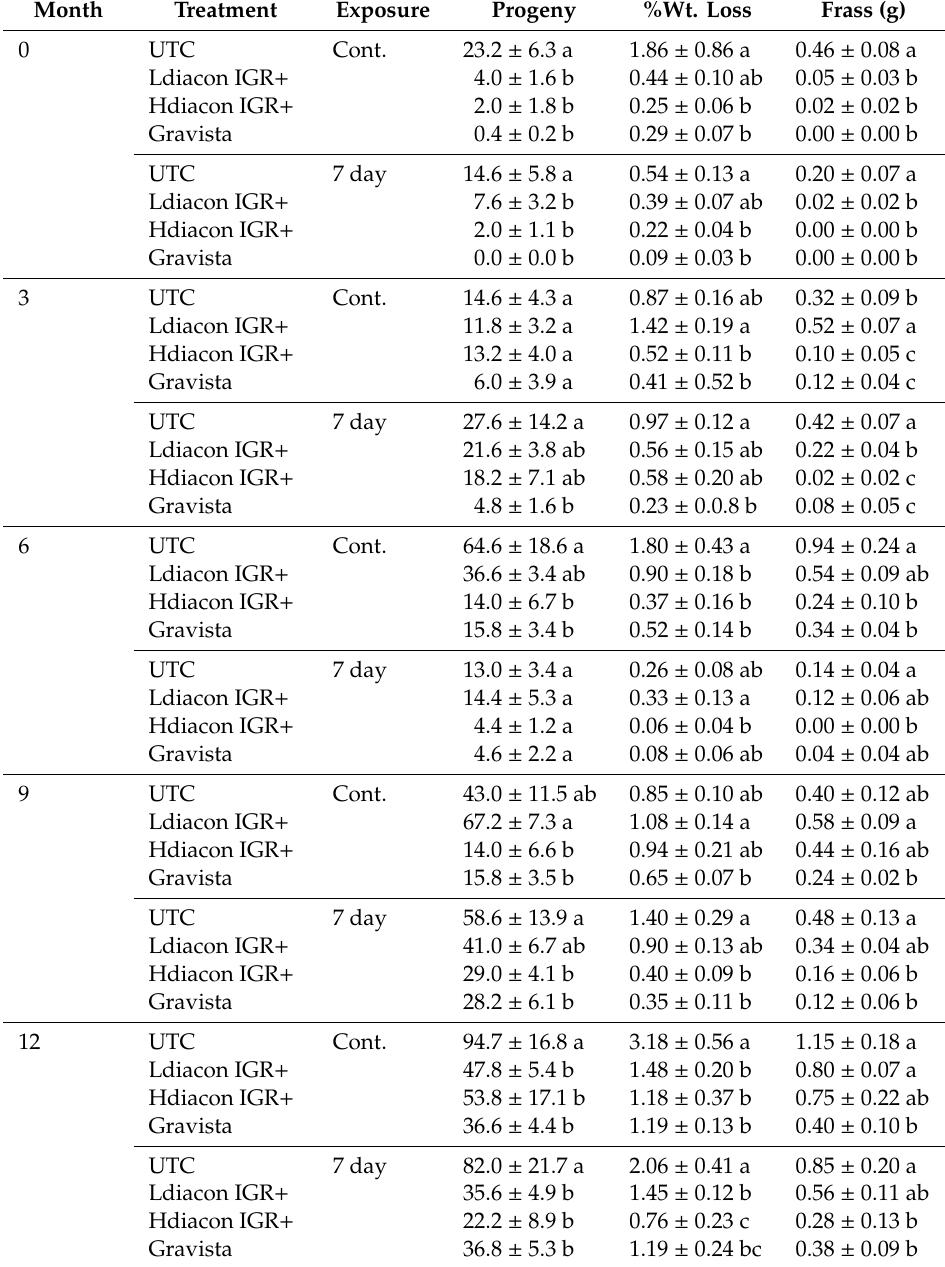
Table 10. Number of F 1 adult progeny, % of sample weight loss due to insect feeding, and feeding damage (frass) (mean ± SE for all) from exposure of ten mixed-sex parental adult S. zeamais exposed on ~80 g of untreated corn (UTC) wheat or corn treated with the low rate of Diacon IGR + (Ldiacon 1.0 ppm + 2.5 ppm methoprene), or the Gravista formulation (methoprene + deltamethrin +